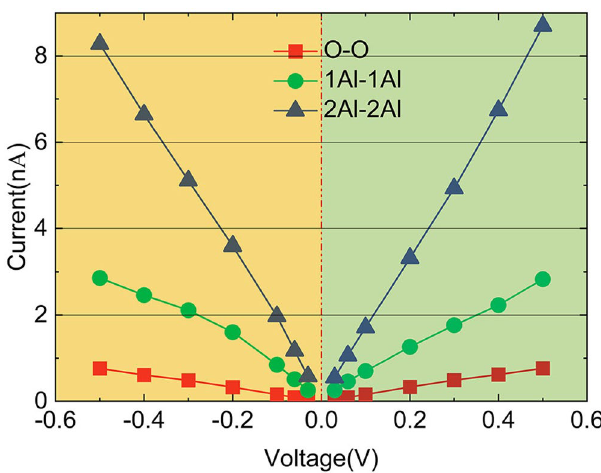
Figure 4. I-V curves for the three different oxide termination models for different voltage polarities. The red, green, and blue lines denote the O-terminated (O), Al-terminated(1Al), and 2Al-terminated (2Al) oxide layer models on both sides of Al 2 O 3 ,